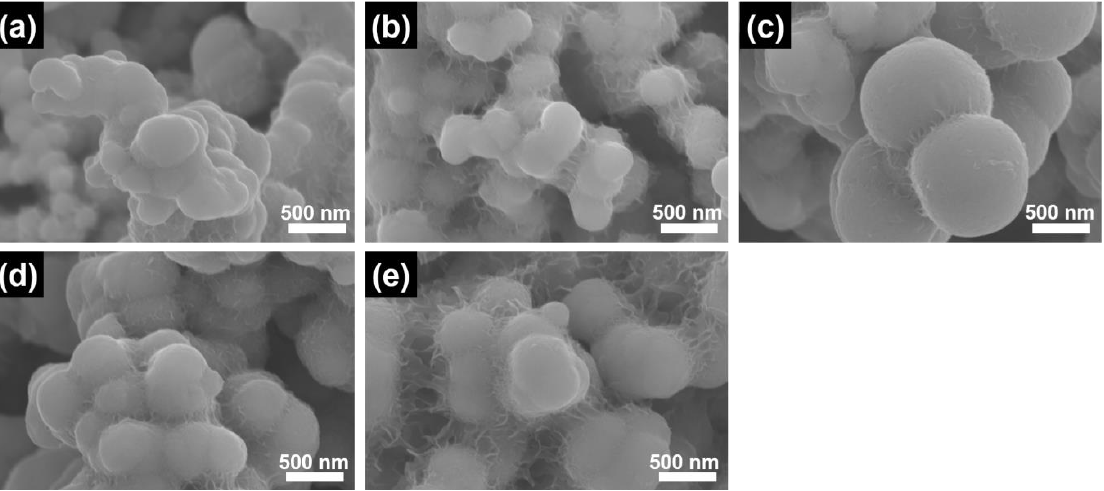
Figure 1. SEM images of Ni nanoparticles synthesized at 80 °C with different concentration